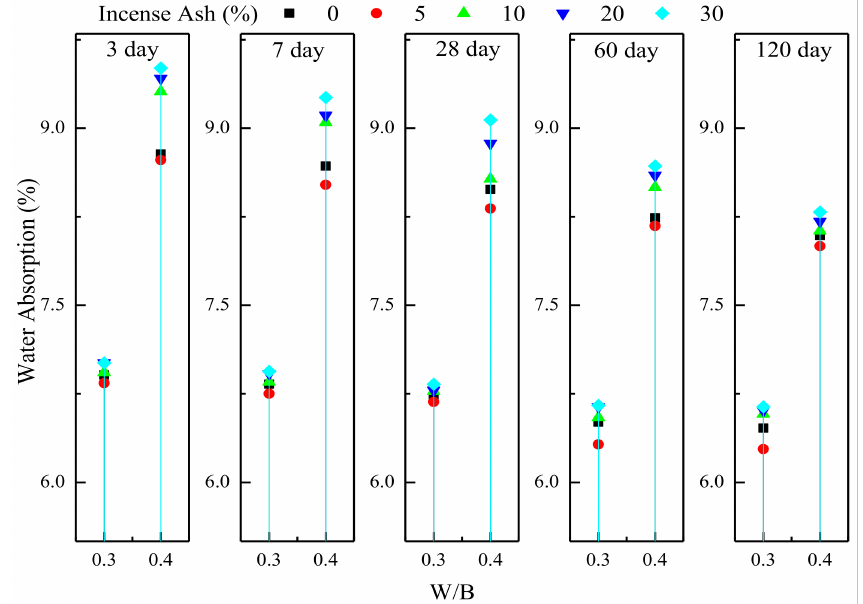
Figure 6. Absorptance rate of incense ash